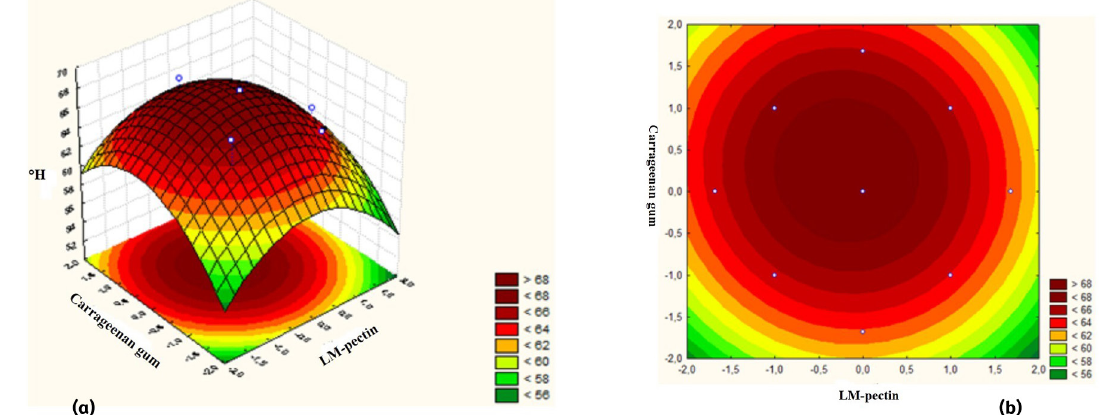
Figure 1. Response surface (a) and contour plot (b) for °Hue of sugar-free banana